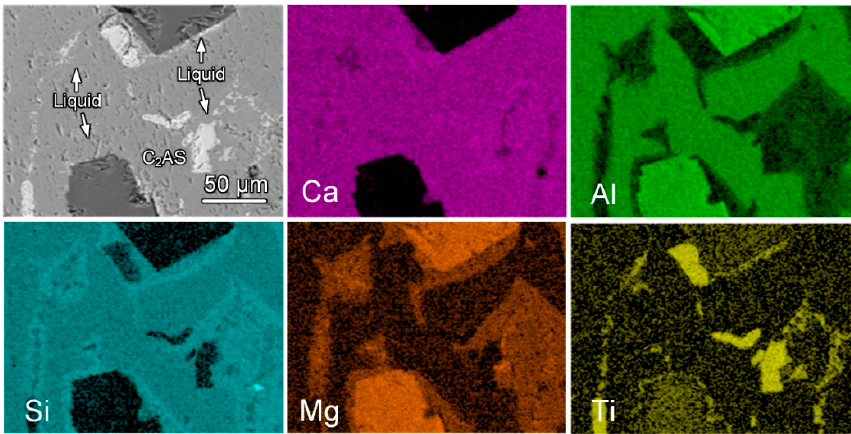
Figure 8. Elemental mappings of Slag B1 at 1310 °C ( R = 2, w (TiO 2 ) = 5%).